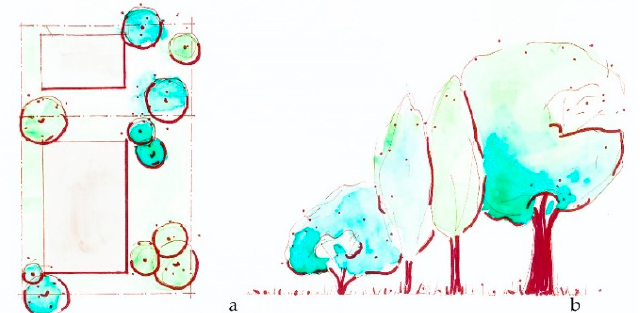
Figure 6. Generate diversity intervention suggests that a mix of plant species of trees and plants within a greenspace is aesthetically pleasing and will increase resilience to future changes in climate. ( a ) Plan view of diverse tree plantings; ( b ) Sketch elevation of diverse tree types.